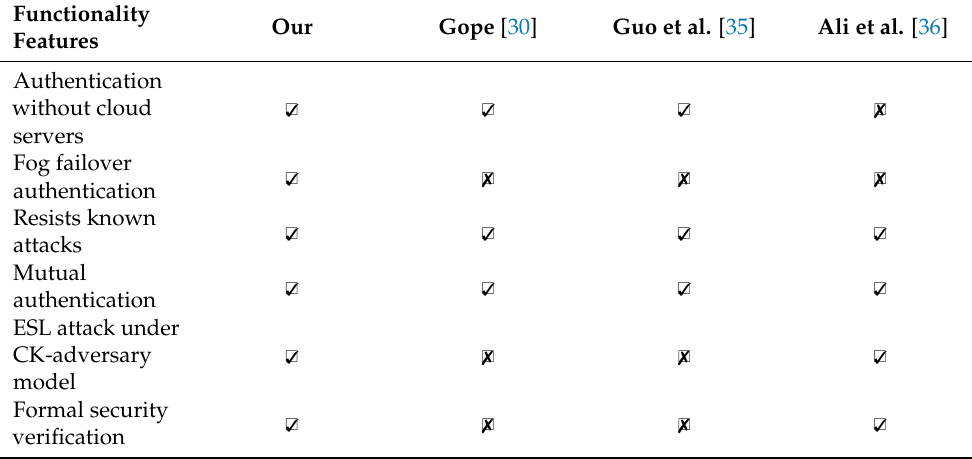
Table 6. Security and functionality features